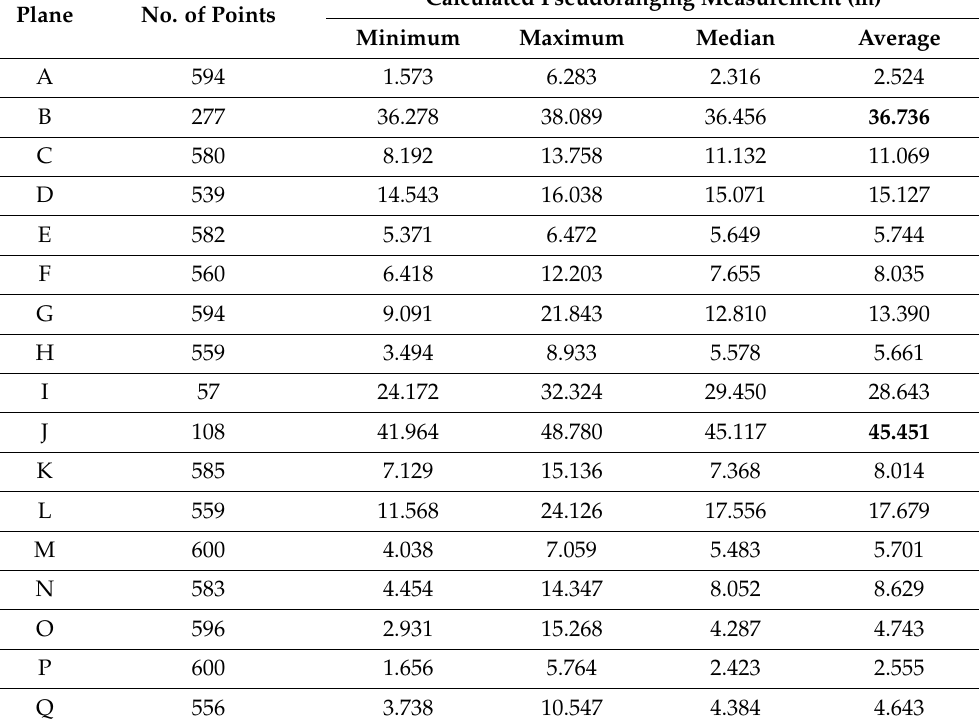
Table 9. The statistics of calculated ranging measurement in each plane after subsampling and blunder removal by the RANSAC algorithm for dataset